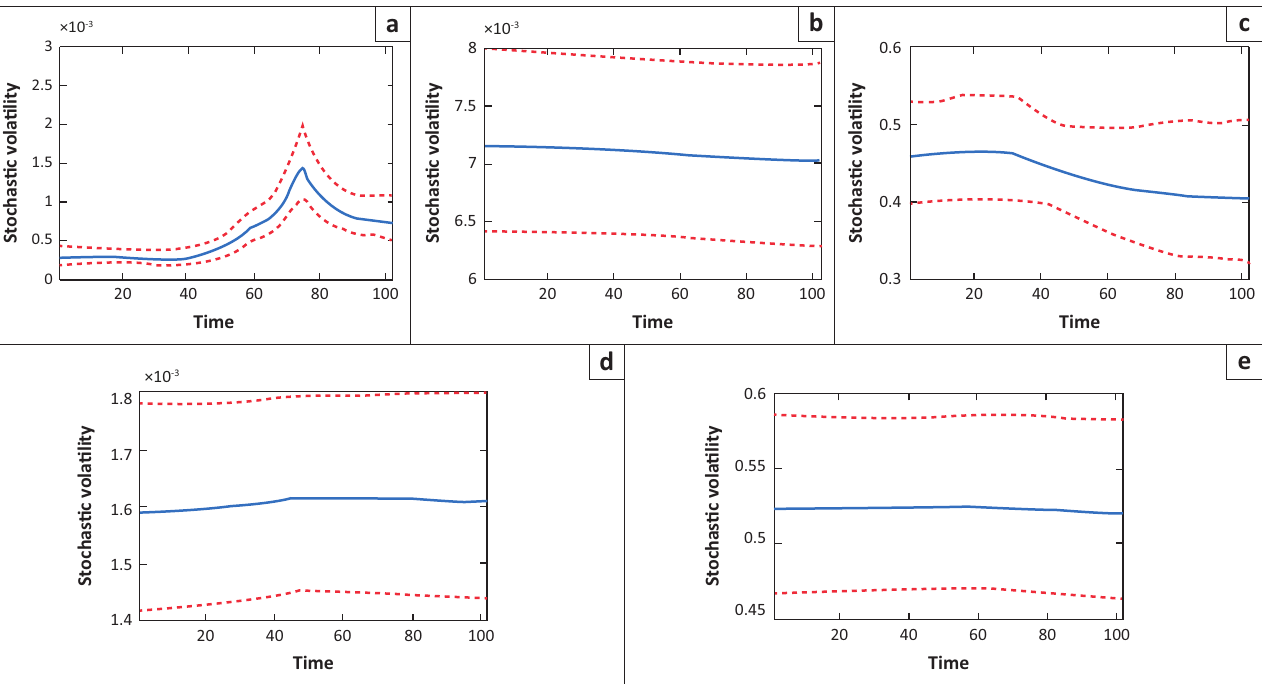
FIGURE 5: Posterior estimates for stochastic volatility of the structural shock: (a) ip; (b) cpi; (c) yield; (d) reer; (e)